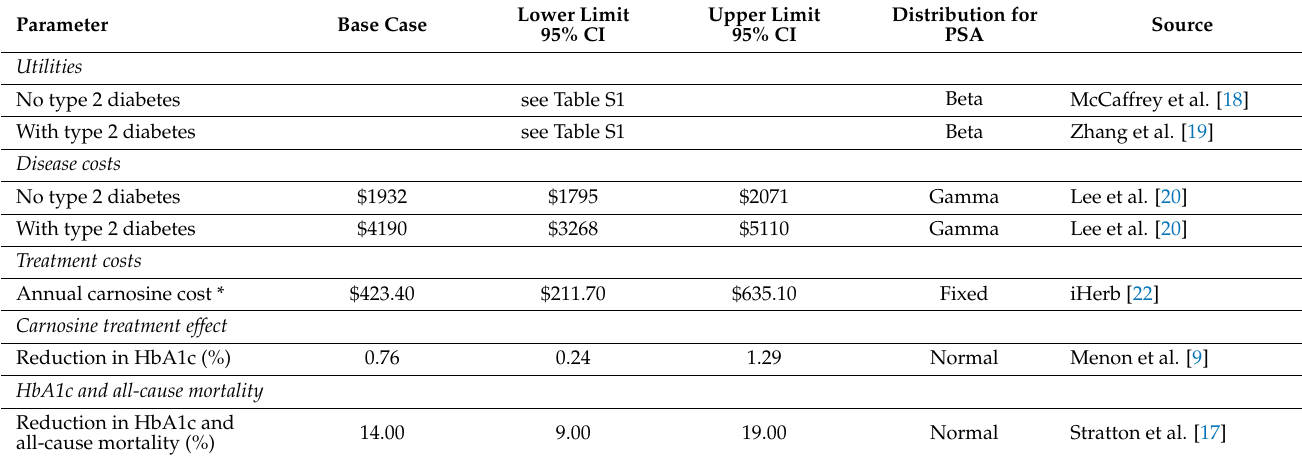
Table 1. Input parameters for the